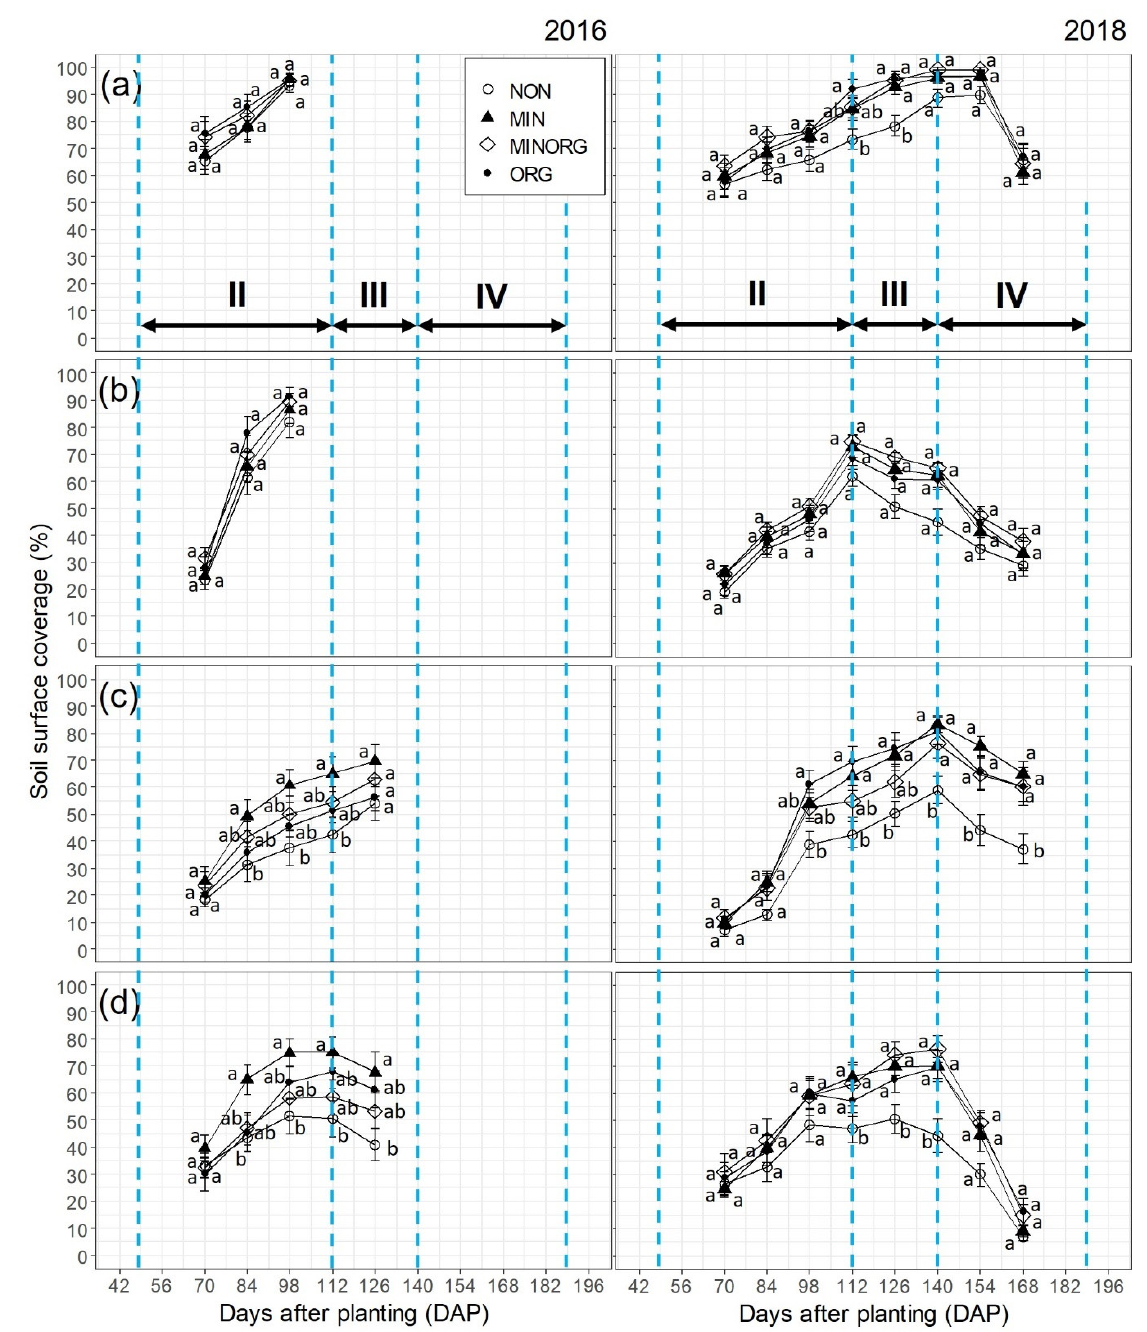
Figure 2. Effect of fertilization regimes on soil surface coverage by water yam above-ground organs in Liliyo ( a ) and Tiéningboué ( b ), both located in Côte d’Ivoire, and Midebdo ( c ) and Léo ( d ), both located in Burkina Faso, in 2016 and 2018. In 2016, SSC was measured using a wooden frame [32] modified by Diby et al. [5], while in 2018, it was measured using Canopeo (Patrignani and Ochsner, 2015). In 2016, the cultivars of water yam were C18 in Liliyo, woroba in Tiéningboué, and florido in Midebdo and Léo, while in 2018, C18 was cultivated in the four sites. Water yam was cultivated in 2018 in the four sites after either a cereal, a legume, or a white yam within a given fertilization regime. For each site and each DAP, different letters denote significant differences between treatments calculated by the Tukey test at p -level ≤ 0.05 ( n = 12 replicates per treatment). II, III, and IV indicate the different growth phases of water yam: phase II from emergence (SE) at 50 DAP to tuber initiation (TI) at 112 DAP; phase III from TI to maximum canopy development (MCD) at 140 DAP; and